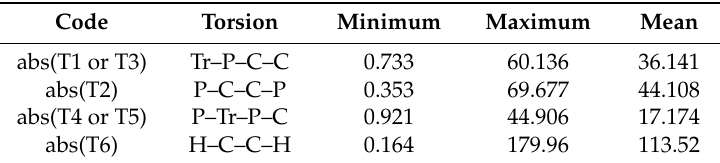
Table 5. Absolute values of the endo- and exocyclic torsions within the five-membered metallacycles found in the Cambridge Structural Database (CSD).